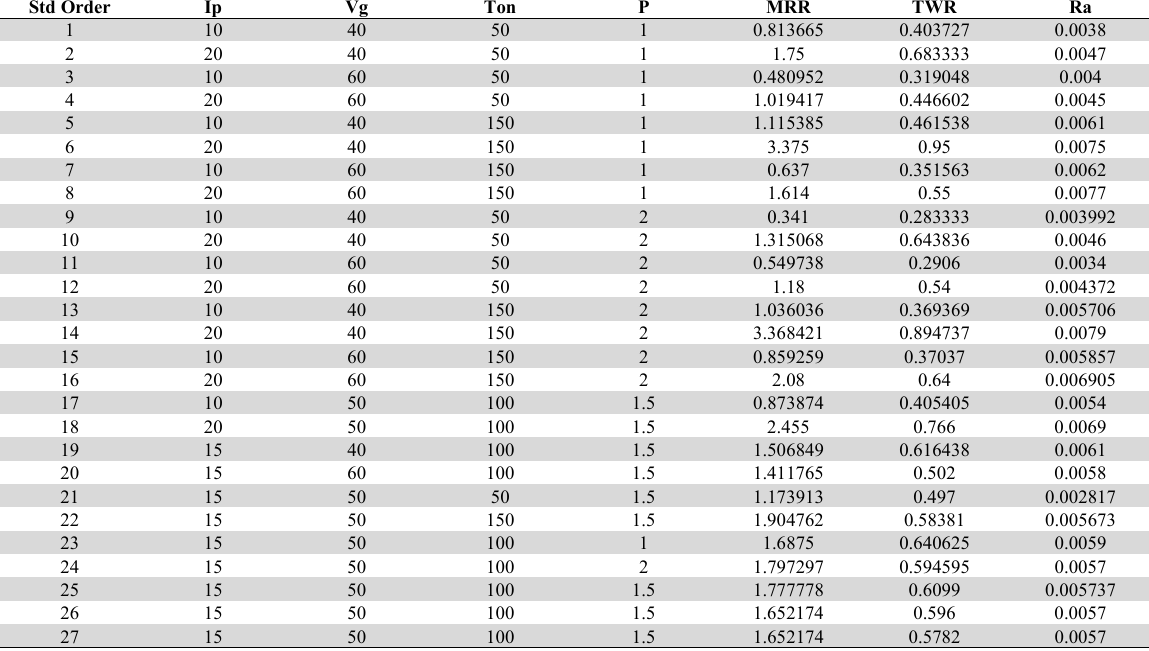
The design matrix showing the levels of inputs and responses Std